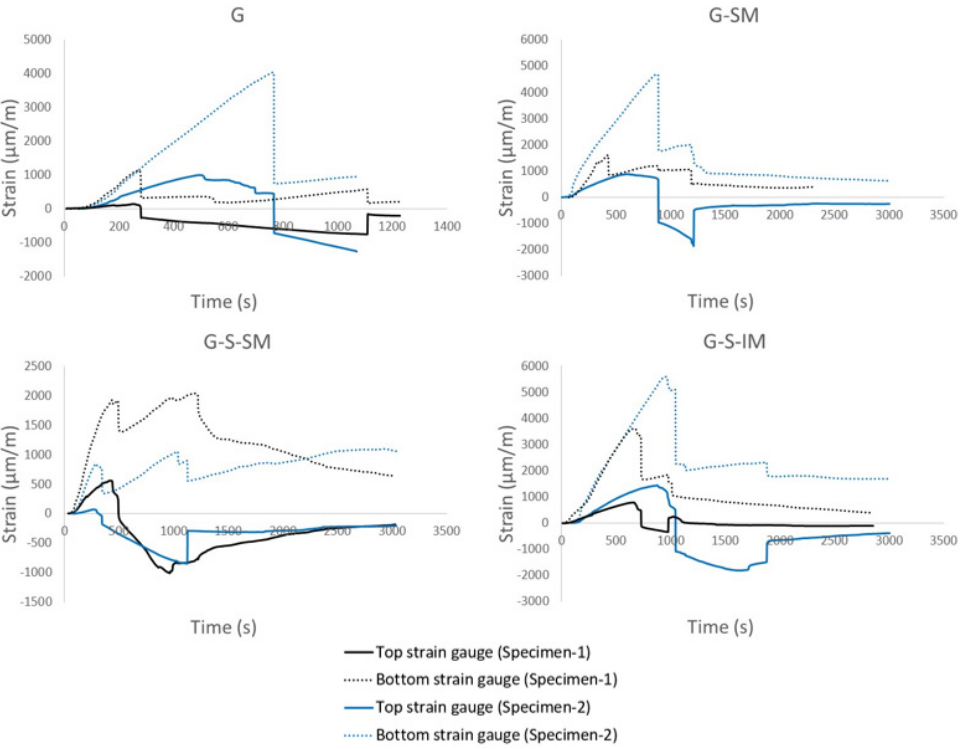
Figure 7. Strain_time plots.